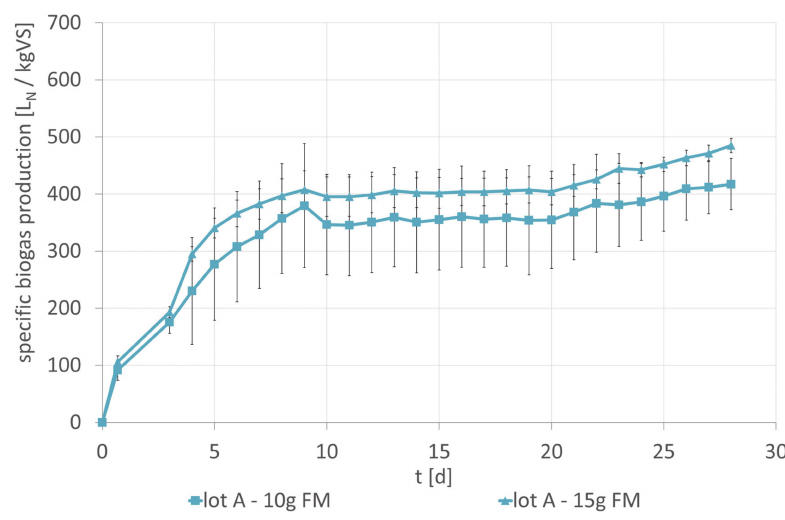
Figure 1. Specific biogas production of ensiled energy cane lot A 10 g FM (result: 417 L N / kg VS ) and lot A 15 g FM (result: 485 L N / kg VS